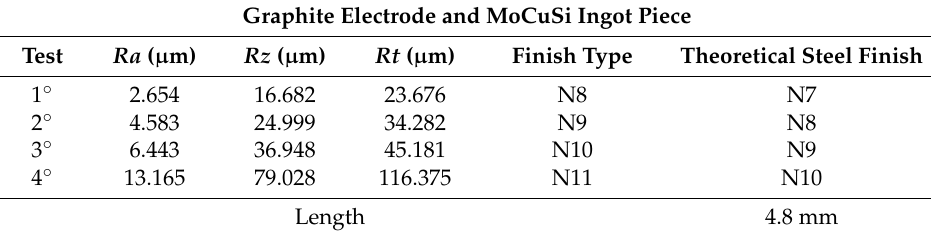
Table 11. Results for surface finish with the ingot MoCuSi.